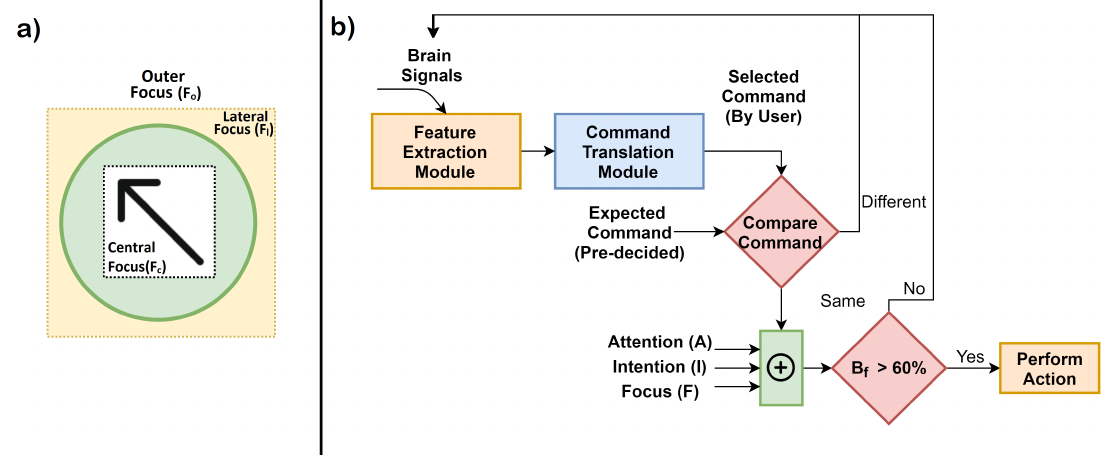
Figure 10. ( a ) Eyeball tracking in grid cell , ( b ) flow chart of the system using neuro-biological fusion (adapted from: [70]).